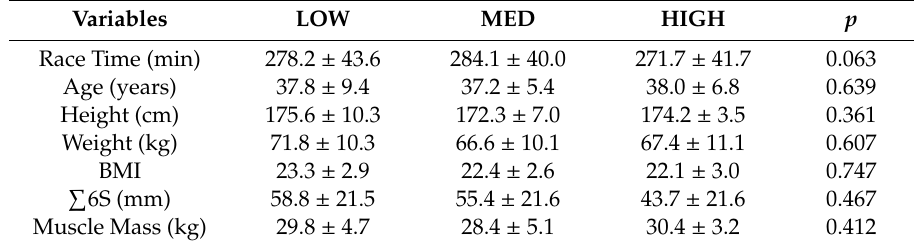
Table 1. Race time, age, anthropometric characteristics and body composition in low (LOW), medium (MED) and high (HIGH) groups at baseline (T1).